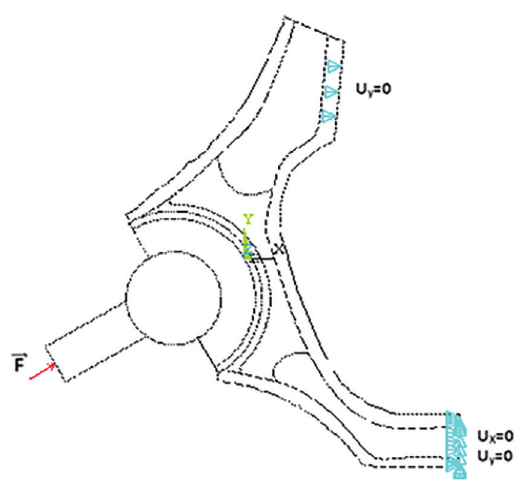
Figure 6: Boundary conditions (0° of the metallic implant